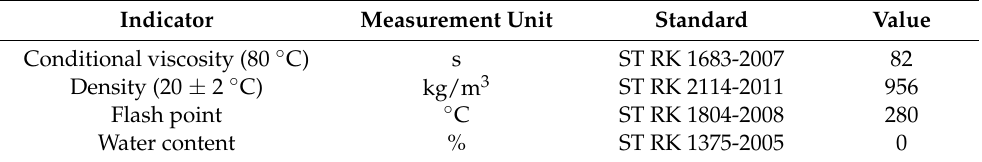
Table 2. Main standard indicators of the